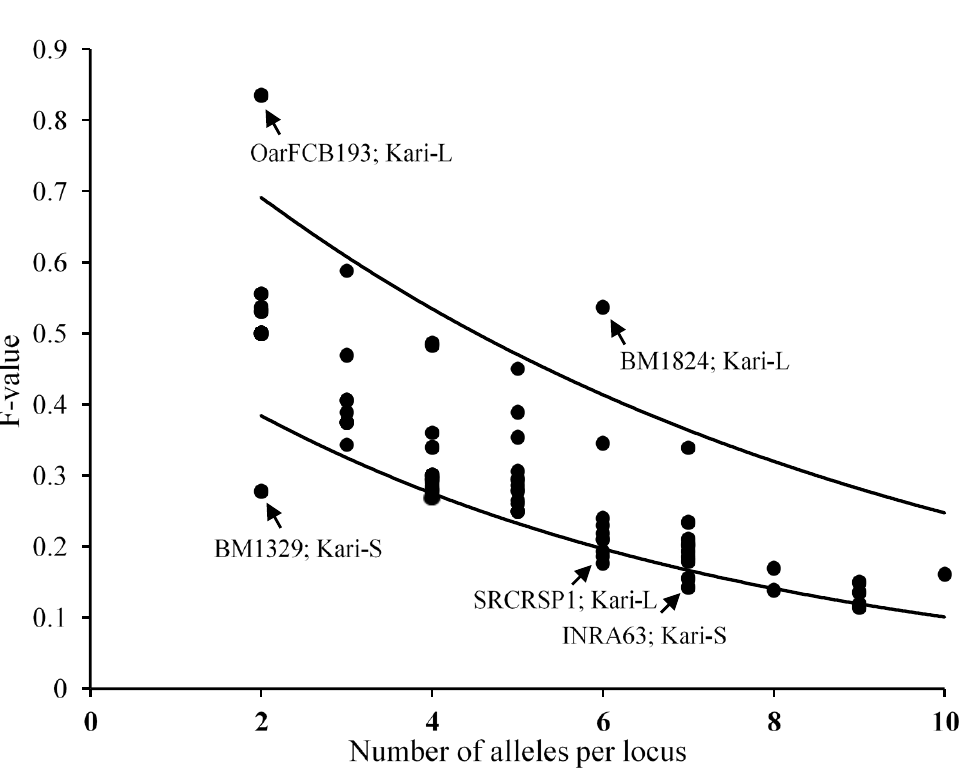
Figure 3. Ewens-Watterson test of neutrality of markers in the three Kari subtypes. The lines represent the upper and lower 95% confidence intervals. The dots show the loci. Arrows showing the markers (labeled) falling outside of the confidence intervals.